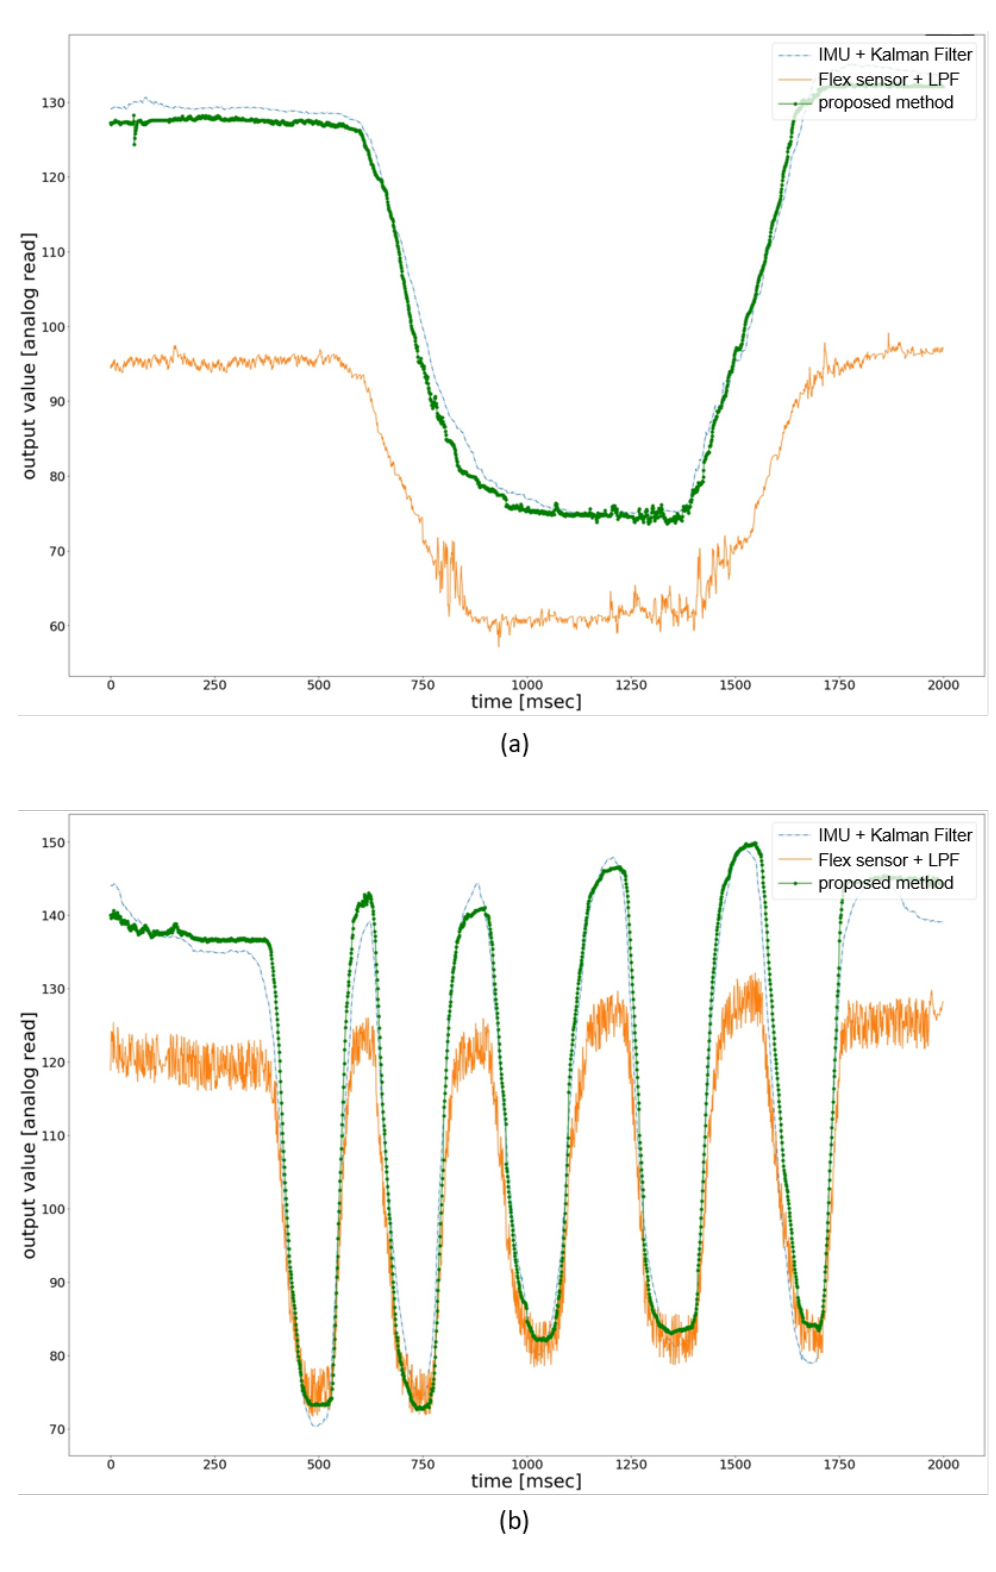
Figure 8. Comparison of the filtered flexion/extension value in terms of noise reduction with method 1(IMU sensor + Kalman filter) and method 2(flex sensor + LPF). ( a ) noise-reduction com- parison for normal flexion/extension movements. ( b ) noise-reduction comparison for fast flex- ion/extension